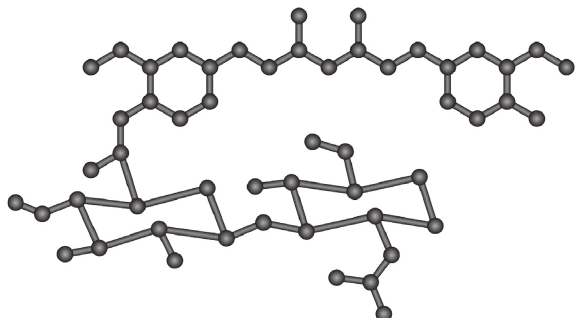
Figure 3: Unit hyaluronic acid-curcumin conjugate (for n � 1).